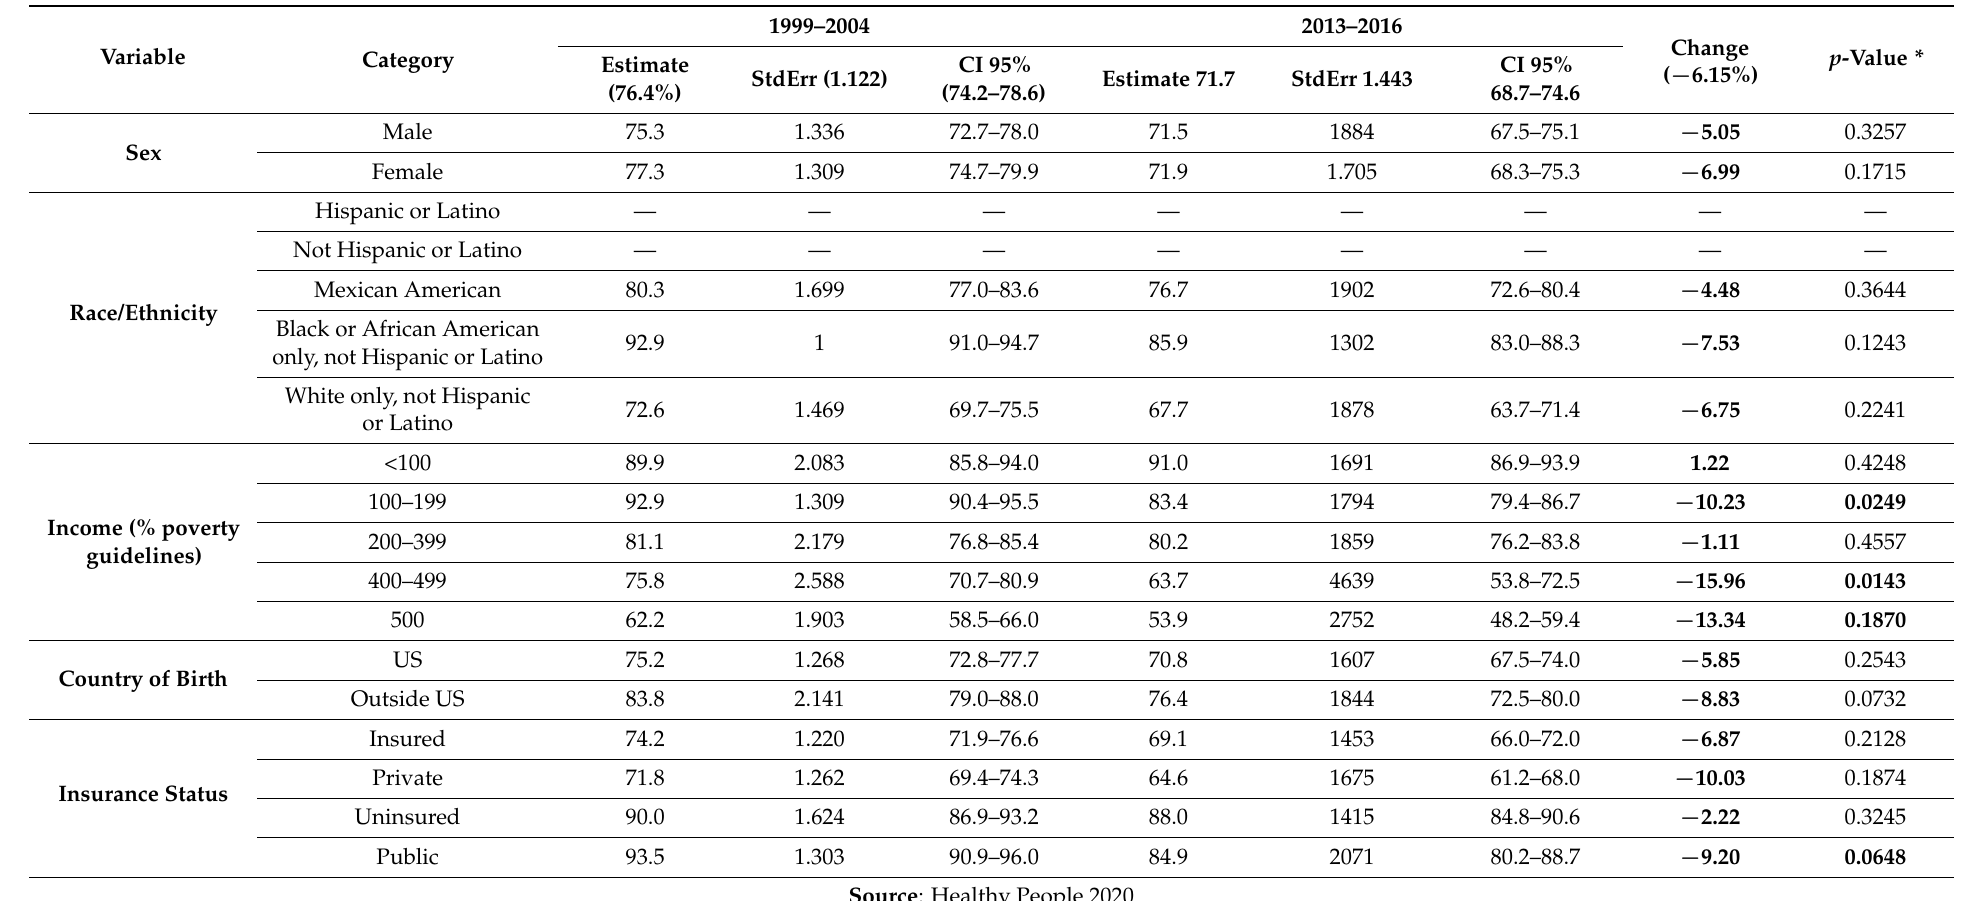
Table 6. Distribution of OH 4.1 permanent tooth extraction 45–64 years, according to sociodemographic characteristics. Healthy People 2020.